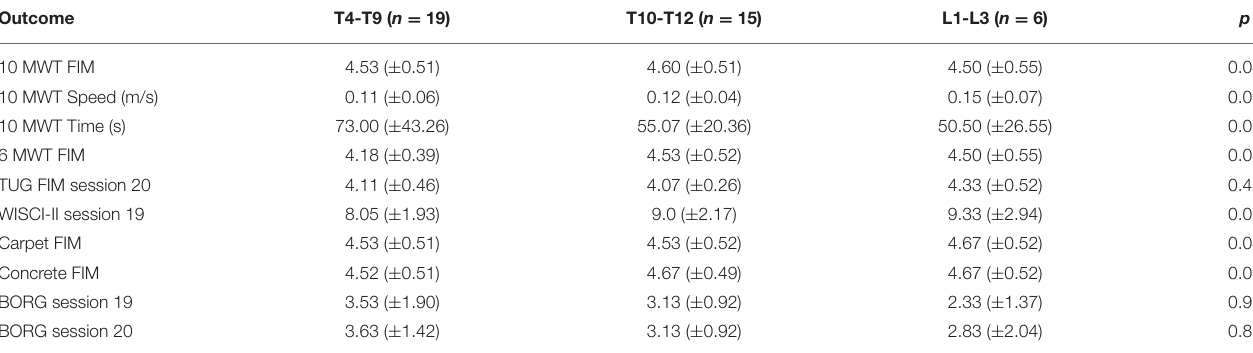
TABLE 6 | Stratification of outcome metrics according to the neurological level of spinal cord injury three groups (T4-9, T10-12, L1-3).